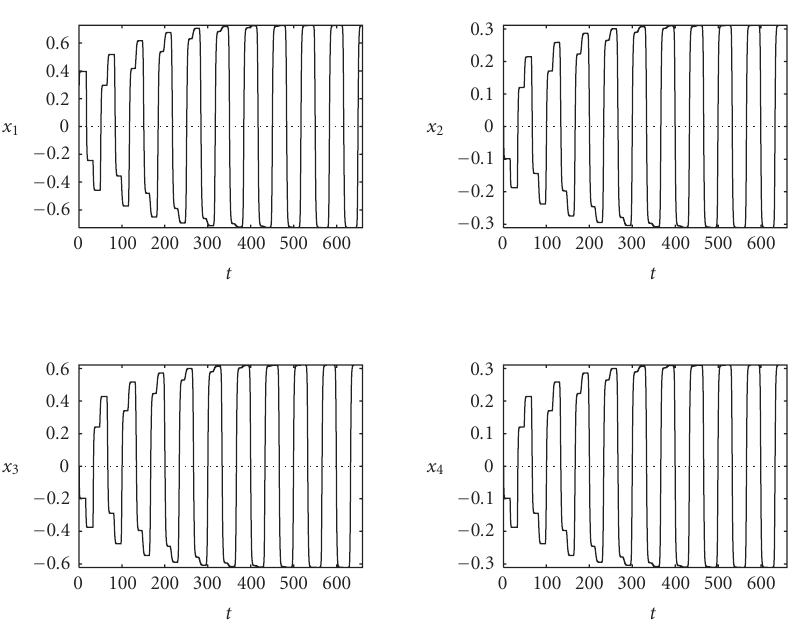
Figure 4.2. The trajectories graphs of system (4.8) with τ 1 = 15 . 46, τ 2 = 16 . 78, and initial data x 1 ( t ) = x 2 ( t ) = x 3 ( t ) = x 4 ( t ) = 0 . 2, t ∈ [ − 16 .